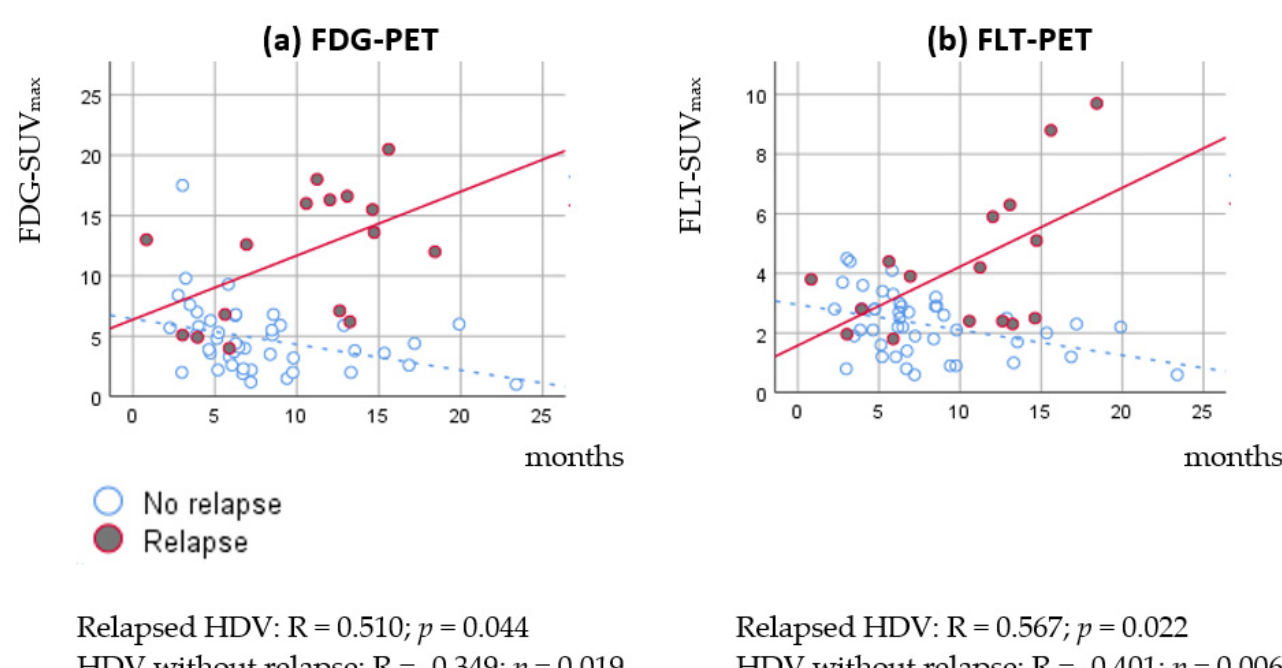
Figure 4. Scatter plot of SUV max in HDV vs. time from the end of radiotherapy to the suspicion of relapse with a linear fit stratified by the relapse status. ( a ) FDG-SUV max ; ( b ) FLT-SUV max .